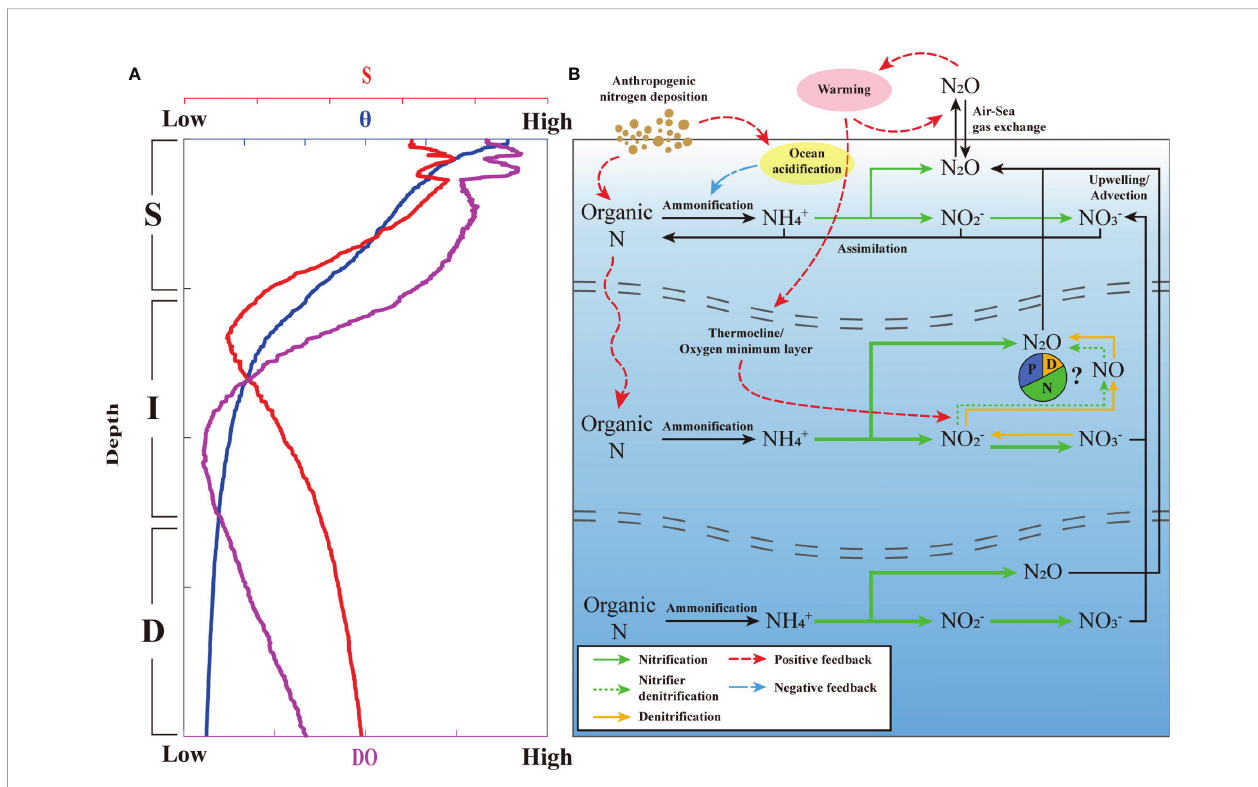
FIGURE 5 | (A) Typical vertical pro fi ling of potential temperature ( q ), salinity (S), and oxygen (DO) concentration during this investigation from the STWNPO. (B) Schematic representation of N 2 O dynamics in this study. The green and yellow solid arrows represent nitri fi cation and potential denitri fi cation processes, respectively, the green dotted arrows represent the nitri fi er denitri fi cation process, and the thickness of the arrows depicts the proportion of the N 2 O production and associated mechanisms within each layer. The red dashed and blue dash-dotted lines represent positive and negative feedback for N 2 O dynamics, respectively. The blue, green, and yellow columns of the pie chart represent the approximate fractions of N 2 O produced through physical (P), nitri fi cation (N), and denitri fi cation (D) processes in the thermocline/oxygen minimum layer (OML), respectively. The estimated N 2 O production for each station is given in the Supplementary Figure S8